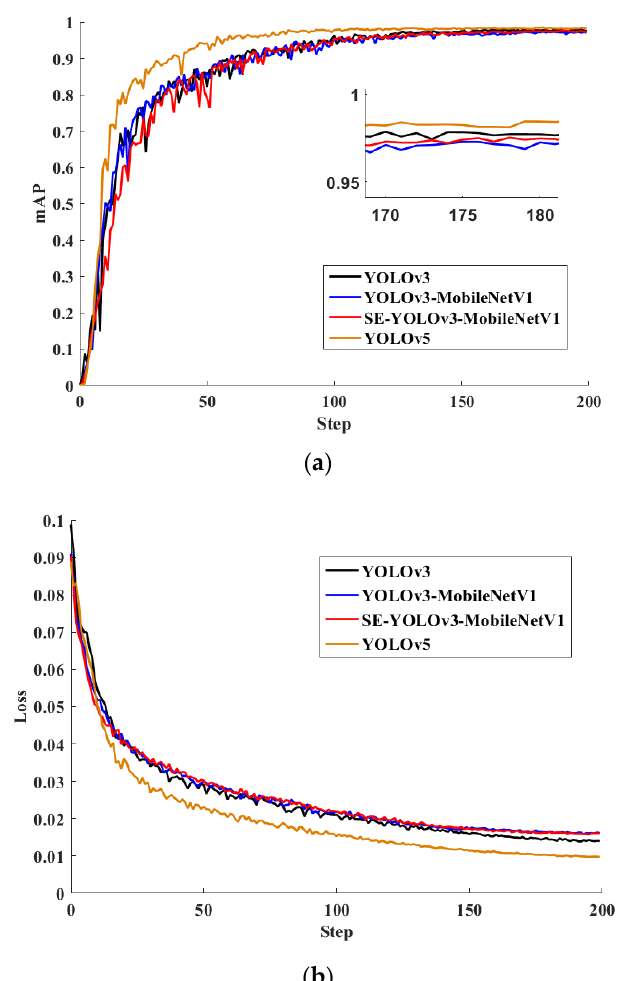
Figure 8. The mAP curve images ( a ) and the loss curve images ( b ) of the four